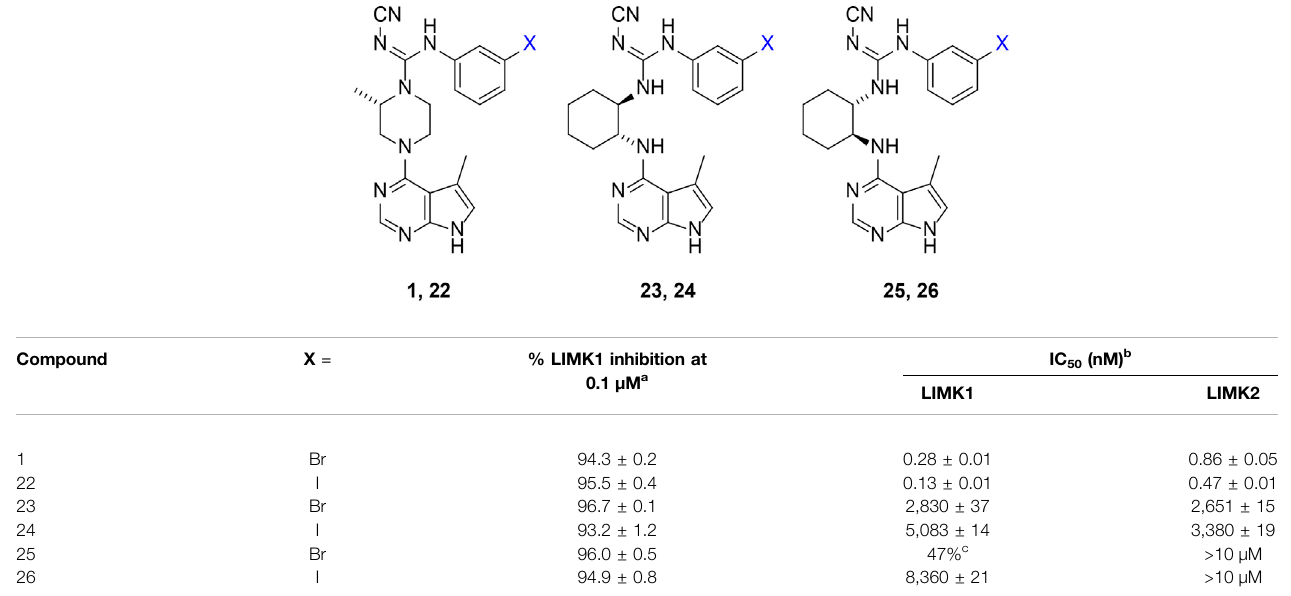
TABLE 2 | Inhibition pro fi le of diaminocyclohexyl linker analogues.